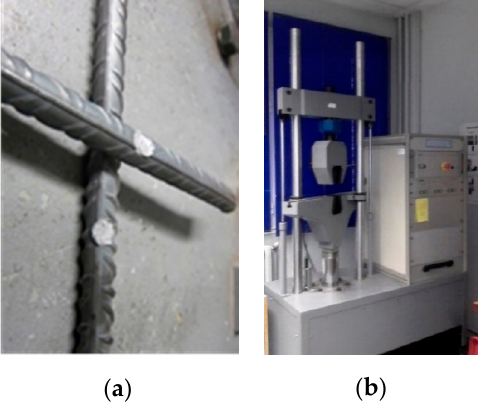
Figure 7. (a ) Broken weld of a test piece, ( b ) Servosis ME-420/20.